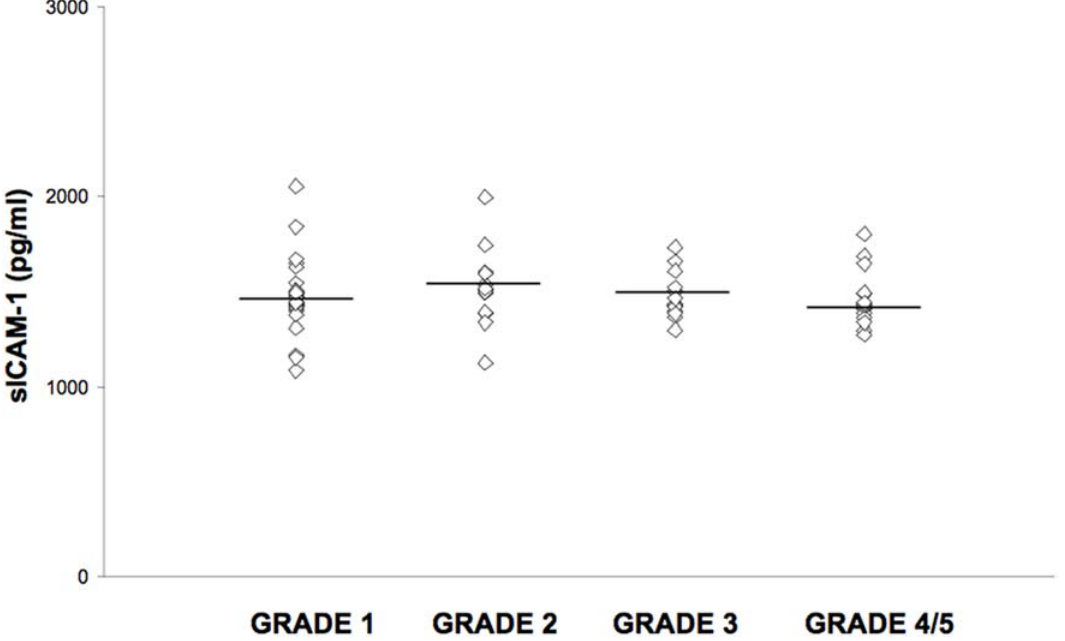
Figure 5. sICAM-1 levels in embryo culture supernatants subdivided into grades as reported in the Methods section.